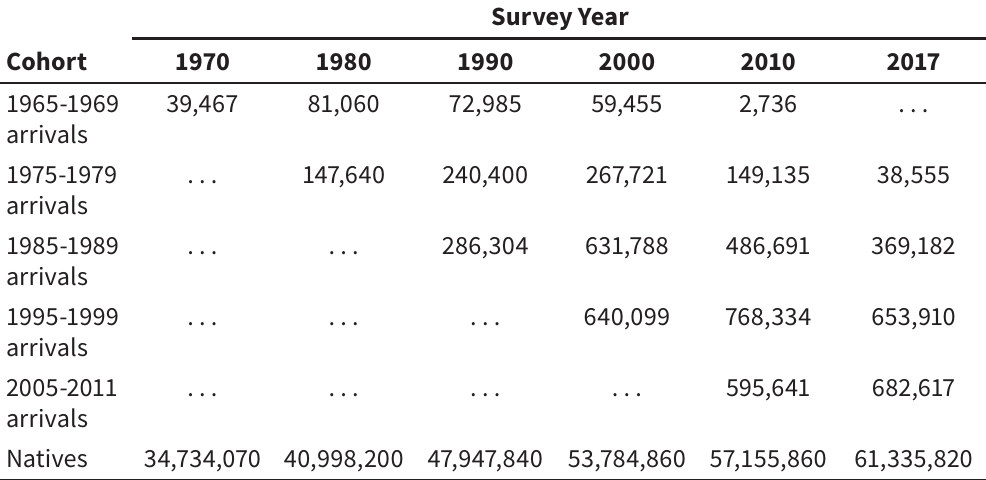
Table A2 Population Estimates for Mexican and Central American Immigrant Cohorts Survey Year